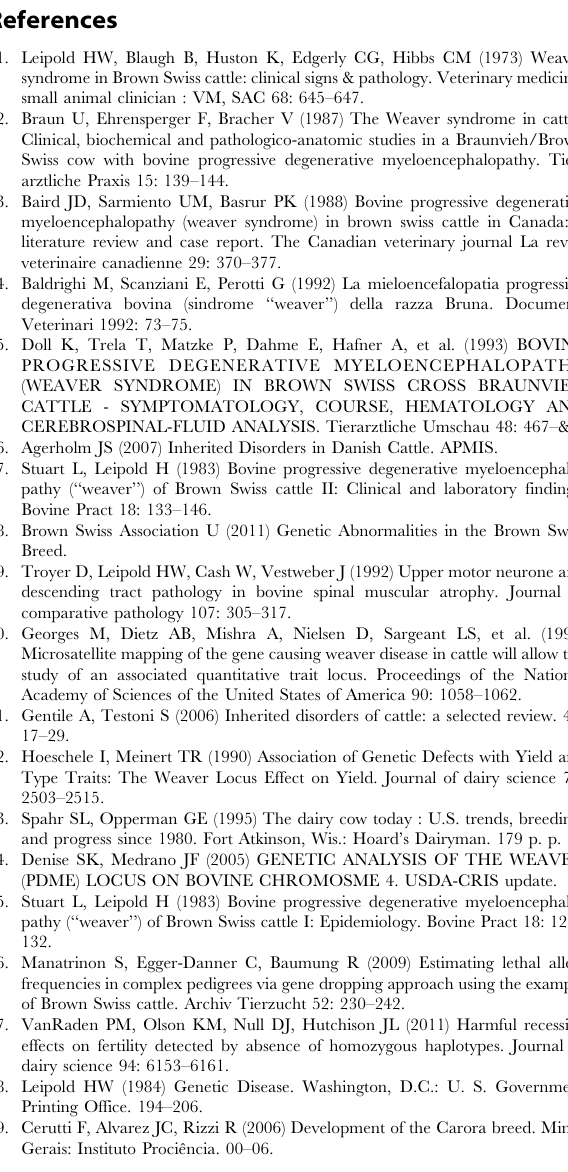
Table S1 Target SNP interactions and filter information. (XLSX) Table S2 140 SNP Weaver Haplotype. (XLSX) Table S3 Target SNP genotpyes and pedigree information. (XLSX) Table S4 Predicted effect of filtered sequence variations. (XLSX) Table S5 Weaver 50K + Target SNP Haplotypes.